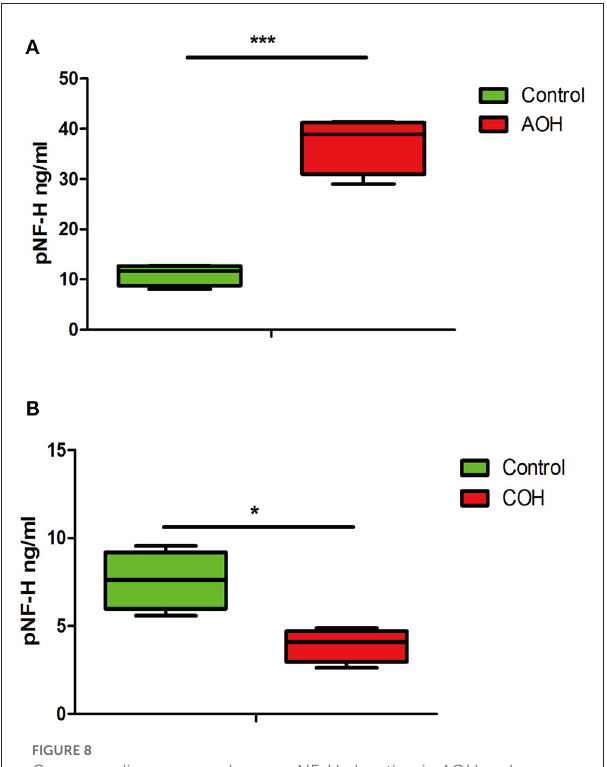
FIGURE8 Corresponding aqueous humor pNF-H elevation in AOH and reduction in COH were observed. (A) Quantification of pNF-H concentration by ELISA in the aqueous humor at 6h after AOH. (B) Quantification of pNF-H concentration by ELISA in the aqueous humor at 4 weeks of COH. All the data are presented as box-and-whisker plots, where the “box” delineates the median and the 25th and 75th quartiles and the “whiskers” show the minimum and maximum values, n = 15 for each group, * P < 0.05, *** P <